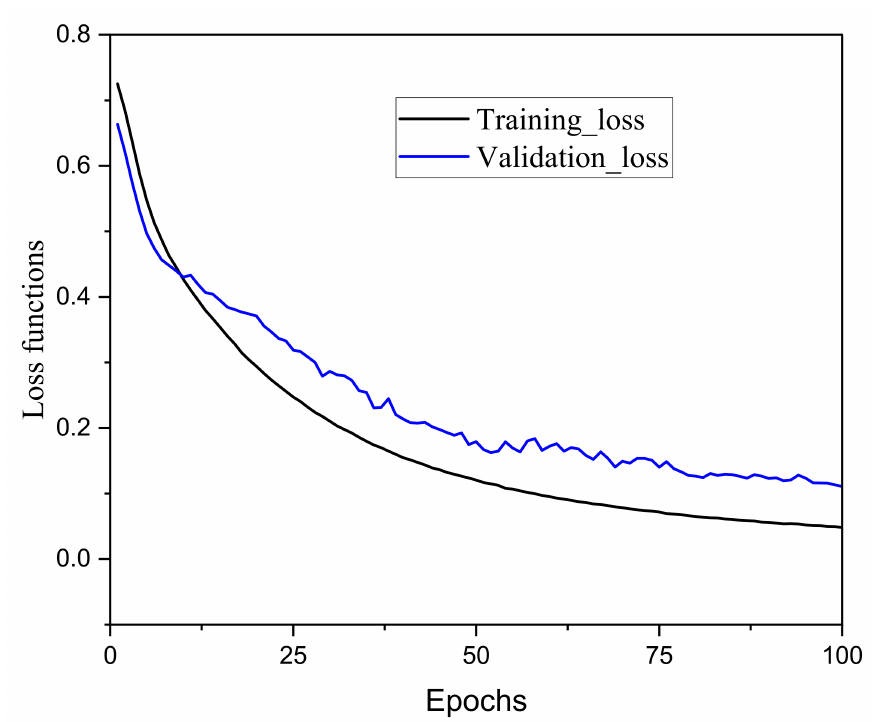
Figure 9. Loss function changes during model